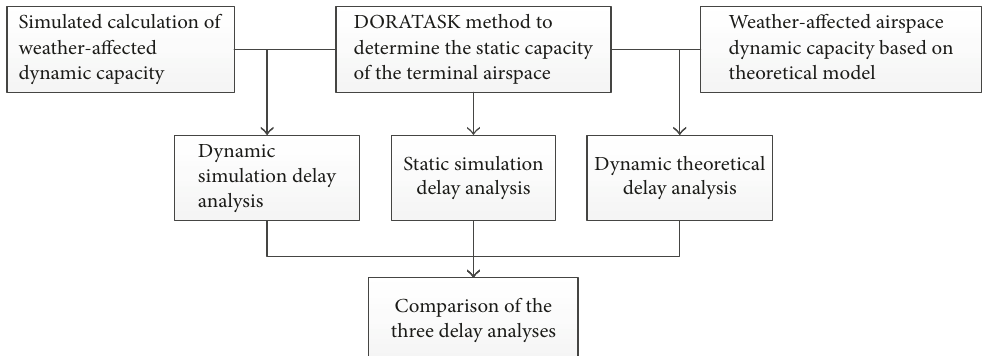
Figure 11: Flowchart of the three delay analyses.